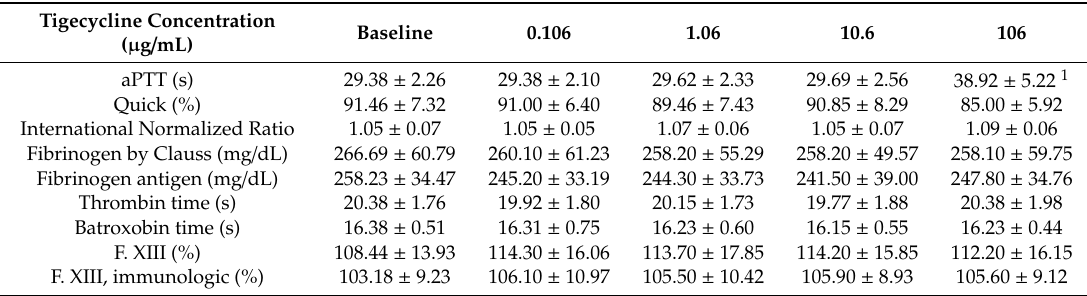
Table 2. Standard coagulation parameters after addition of tigecycline in increasing concentrations ( n =